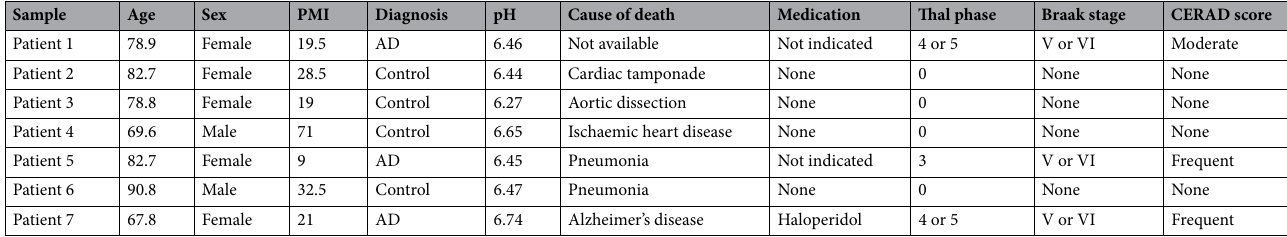
Table 9. Case information of source of human post-mortem MTG tissue. Shows age at death, self-reported gender, post-mortem interval (PMI; hours), diagnosis, pH of tissue, immediate cause of death, medication taken (if any), and post-mortem